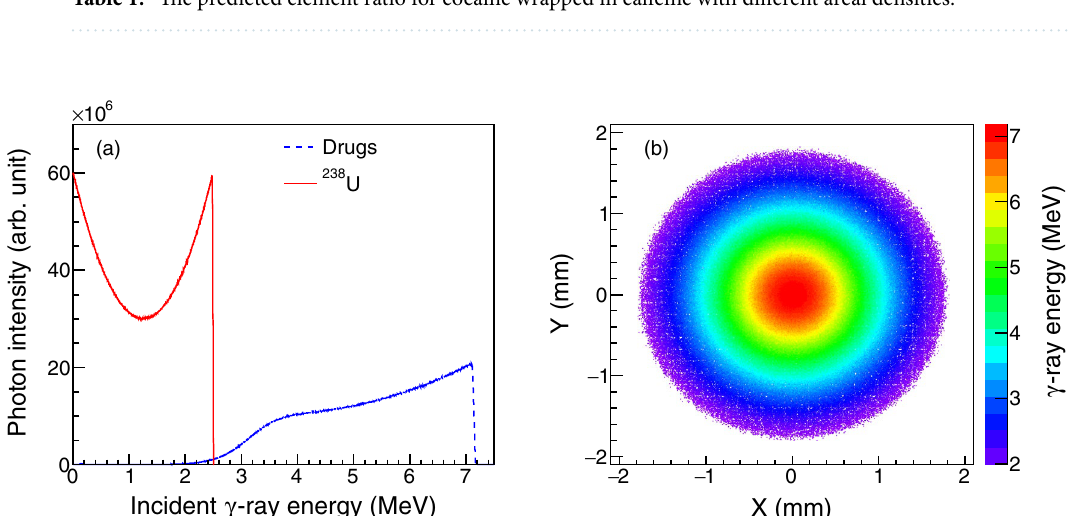
Figure 6. ( a ) Spectral distributions of LCS γ -ray beams incident upon the 238 U and drug targets. ( b ) Spatial distribution of LCS γ -ray beam incident upon the drug